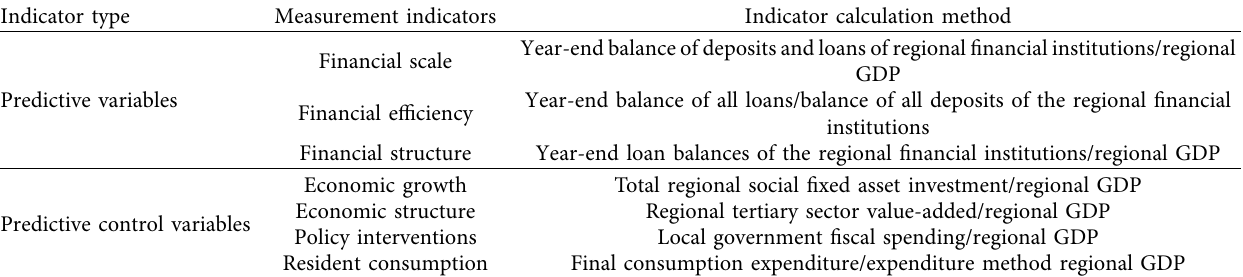
Table 1: The synthetic control method index system.